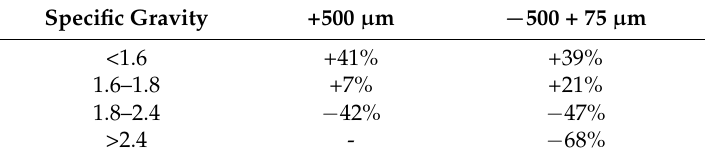
Table 2. Percentage change in the calorific value of various destiny fractions compared to the NMF.